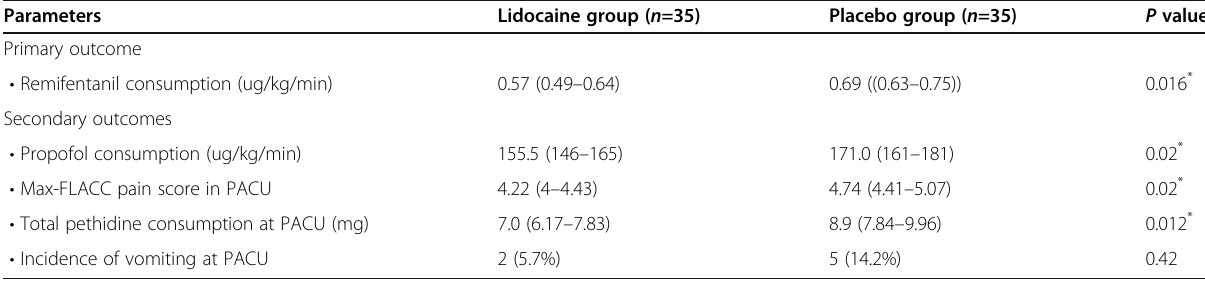
Table 2 Primary and secondary outcomes in the two groups